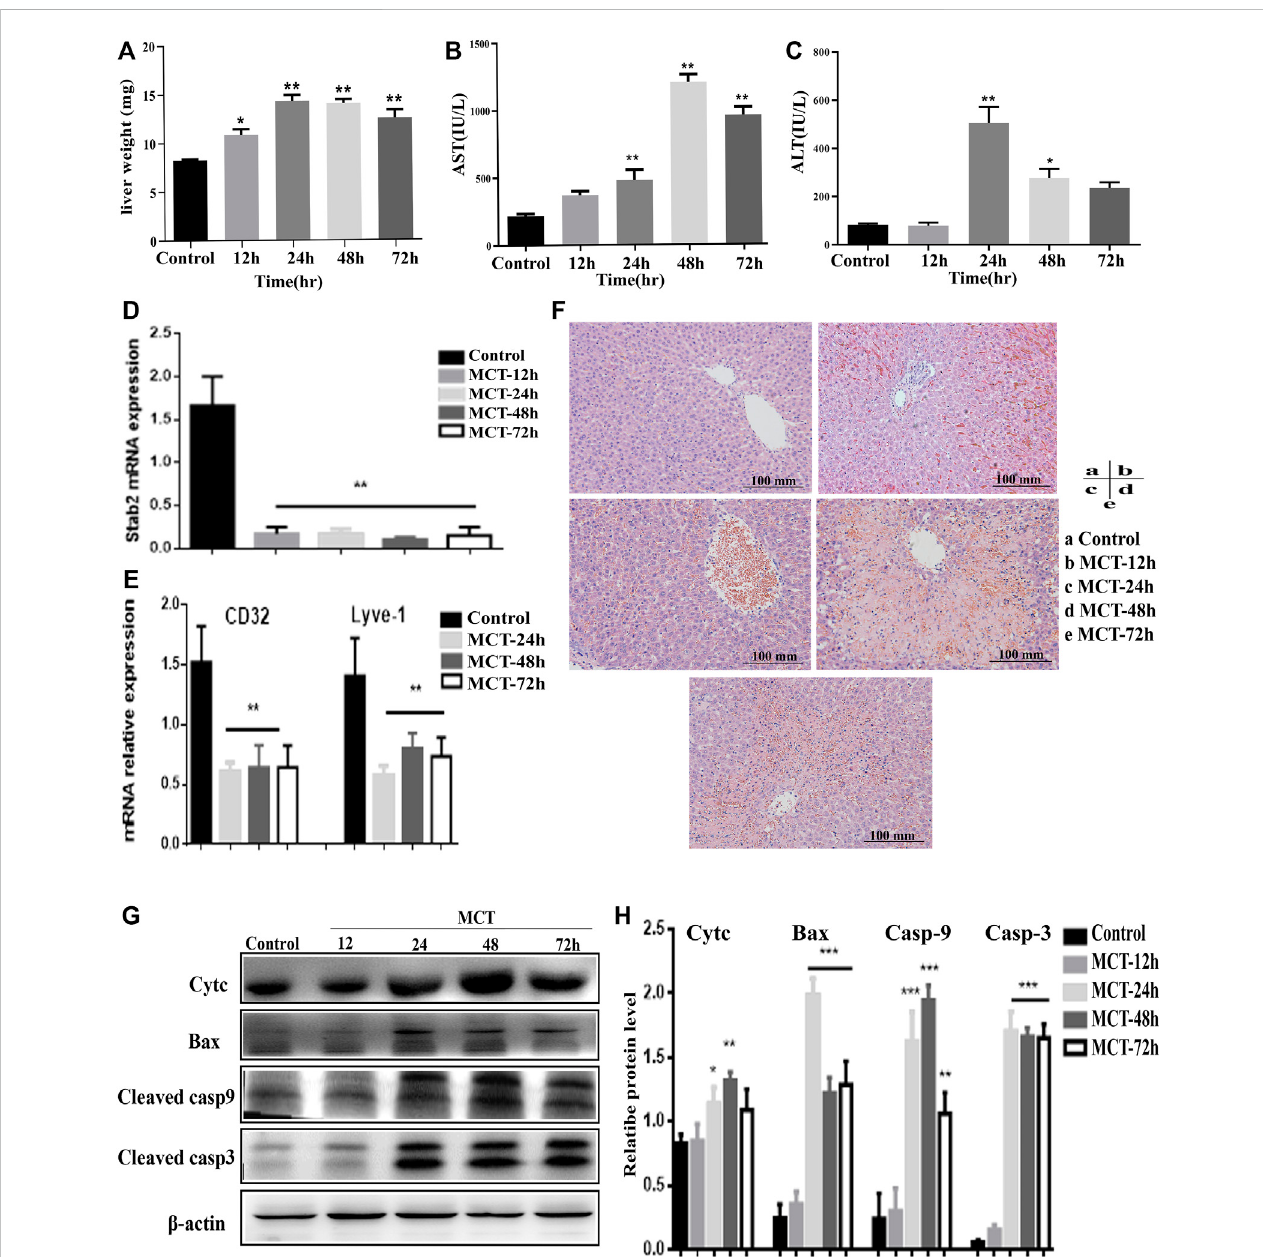
FIGURE 2 ModelofhepatotoxicityinducedbyMCT.160 mg/kgofMCTwasadministeredorallytoratsfordifferentperiodsoftime(12,24,48,and72 h).Featuresof HSOS wereobserved after 48 h, while earlier featuresof hepatotoxicity occurred at12 hofMCTtreatment. (A) Changeinrat liverweightafter MCTtreatment (normalizedtototalbodyweight). (B,C) Bloodserumlevelsofliverenzymes(AST,ALT). (D) RelativeexpressionofmRNAsrelatedtoLSEC-speci fi cgeneStab2. (E) Relative mRNA expression of CD31 and Lyve1. (F) HE images of liver sections. (G) Western blot images indicating expression of cyt c, Bax, cleaved casp-9and-3,and β -actinprotein. (H) Quanti fi cationofimmunoblottingresultsfor apoptoticproteins.Dataarepresentedintheformmean±SD( n =6rats). * p ≤ 0.05; ** p ≤ 0.01; *** p ≤ 0.001 in comparisons of the MCT-treated group against the control group. Scale bars = 100